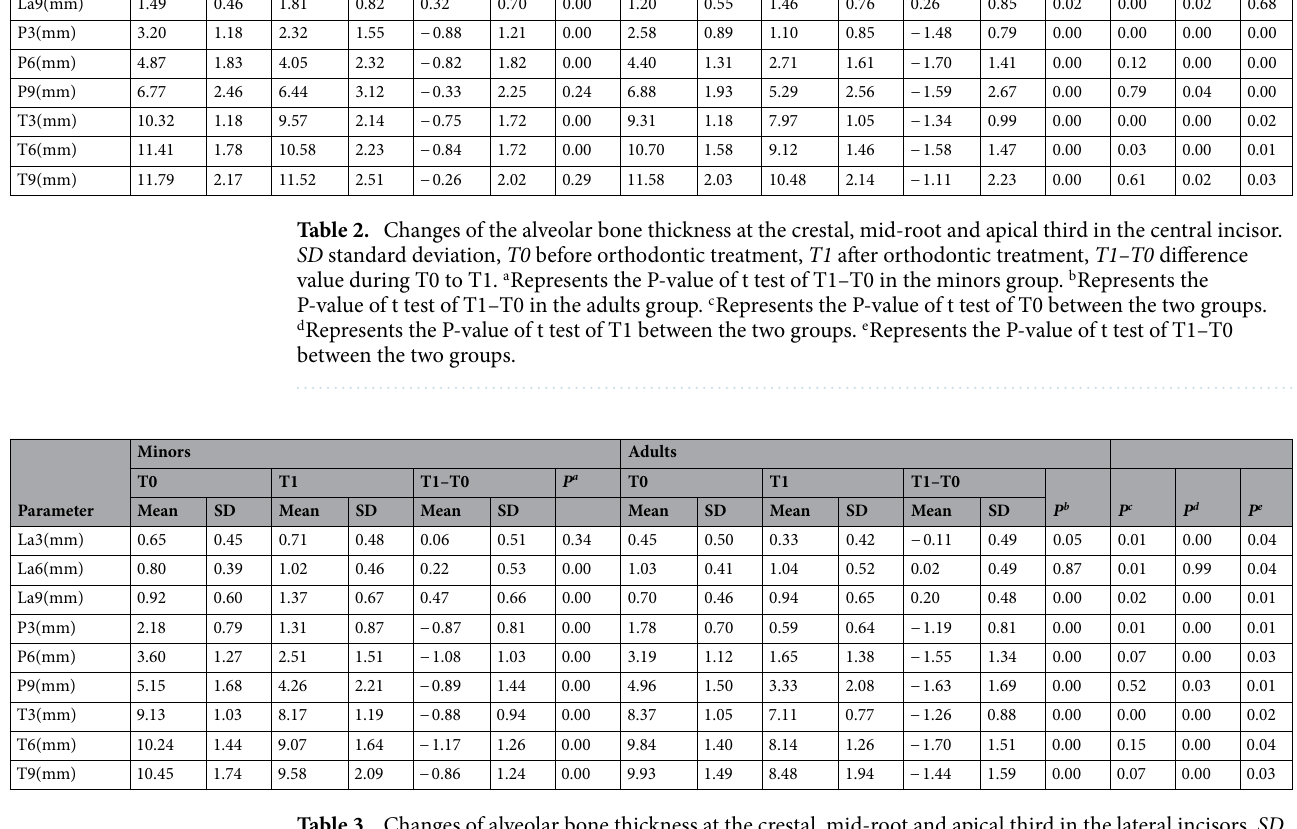
Table 3. Changes of alveolar bone thickness at the crestal, mid-root and apical third in the lateral incisors. SD standard deviation, T0 before orthodontic treatment, T1 after orthodontic treatment, T1–T0 difference value during T0 to T1. a Represents the P-value of t test of T1–T0 in the minors group. b Represents the P-value of t test of T1–T0 in the adults group. c Represents the P-value of t test of T0 between the two groups. d Represents the P-value of t test of T1 between the two groups. e Represents the P-value of t test of T1–T0 between the two groups.